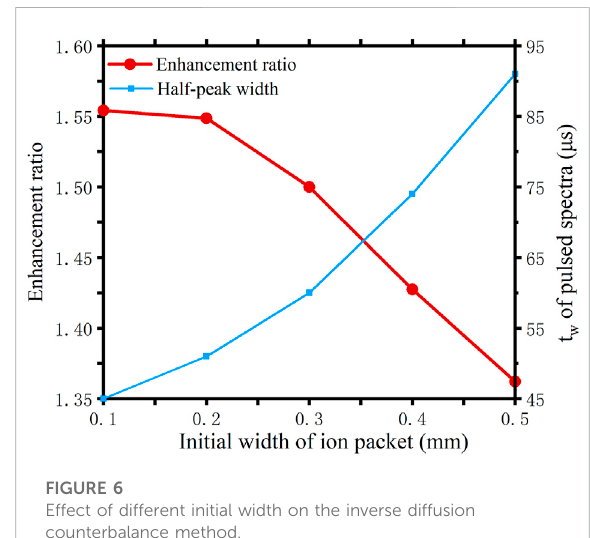
Results obtained by the pulsed method and the inverse diffusion counterbalance method, when ions with close diffusion coef fi cients are sampled simultaneously.